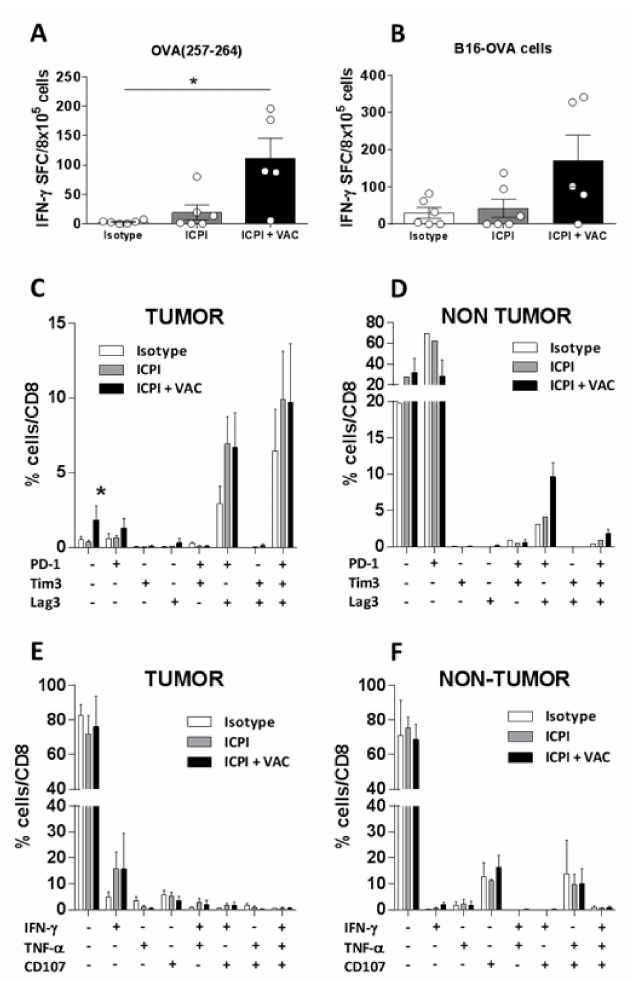
Figure 3. Combined treatment with OVA-CIRP and ICPI promotes antitumor T-cell responses which are exhausted in the tumor. Spleens from mice ( n = 5–6) with hepatic B16-OVA tumors treated with isotype control antibodies, ICPI or ICPI plus vaccine were obtained at day 25 after treatment, homogenized and cells stimulated with peptide OVA (257–264) ( A ) or with irradiated tumor cells ( B ). In both cases, responses were measured by ELISPOT. Livers from 3 representative animals from each group were also obtained and CD8 T-cells specific for OVA (257–264) in tumor ( C ) and non-tumor liver tissue ( D ), labelled as Tet + , were analyzed by flow cytometry, determining the combined expression of inhibitory receptors PD-1, Tim-3 and Lag3. Intrahepatic lymphocytes from tumor ( E ) and non-tumor ( F ) tissue were stimulated with PMA and ionomycine and combined e ff ector functions (expression of cytokines IFN- γ and TNF- α , and of the cytotoxicity marker CD107) were determined by flow cytometry 4 h later. *, p <